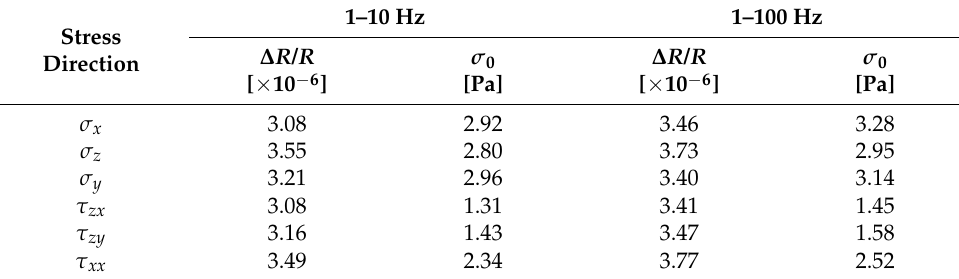
Table 5. Minimum detectable Table 4. Noise levels of each element.